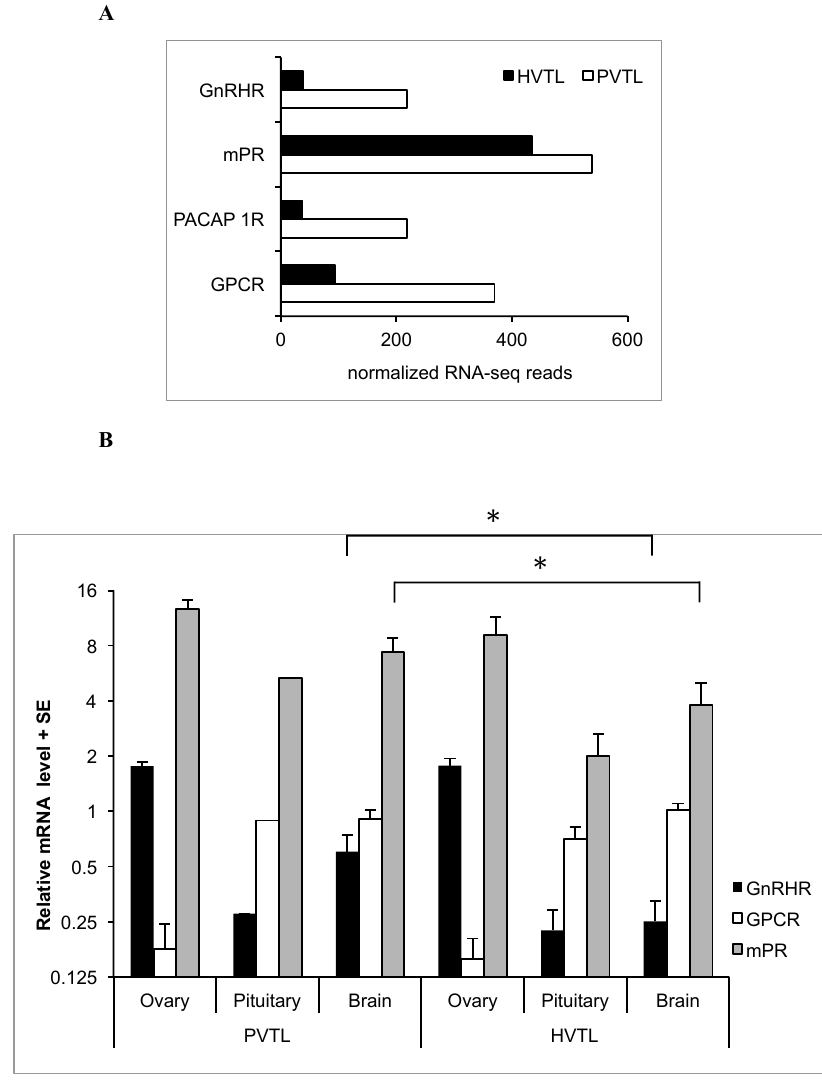
Figure 3. ( A ). mRNA levels (based on normalized RNA-seq reads) of gonadotropin-releasing hormone II receptor (GnRH IIR), pituitary adenylate cyclase-activating polypeptide type I receptor (PACAP 1R), membrane progesterone receptor epsilon (mPR) and G-protein coupled receptor 54 (GPCR) in the brains of blue gourami females at di ff erent stages of oogenesis: PVTL and HVTL. ( B ). Relative mRNA levels (based on qRT-PCR) of GnRH IIR, mPR, and GPCR in the brains of blue gourami females at di ff erent stages of oogenesis: PVTL and HVTL. Bars: S.E. from n = 5. *: P <